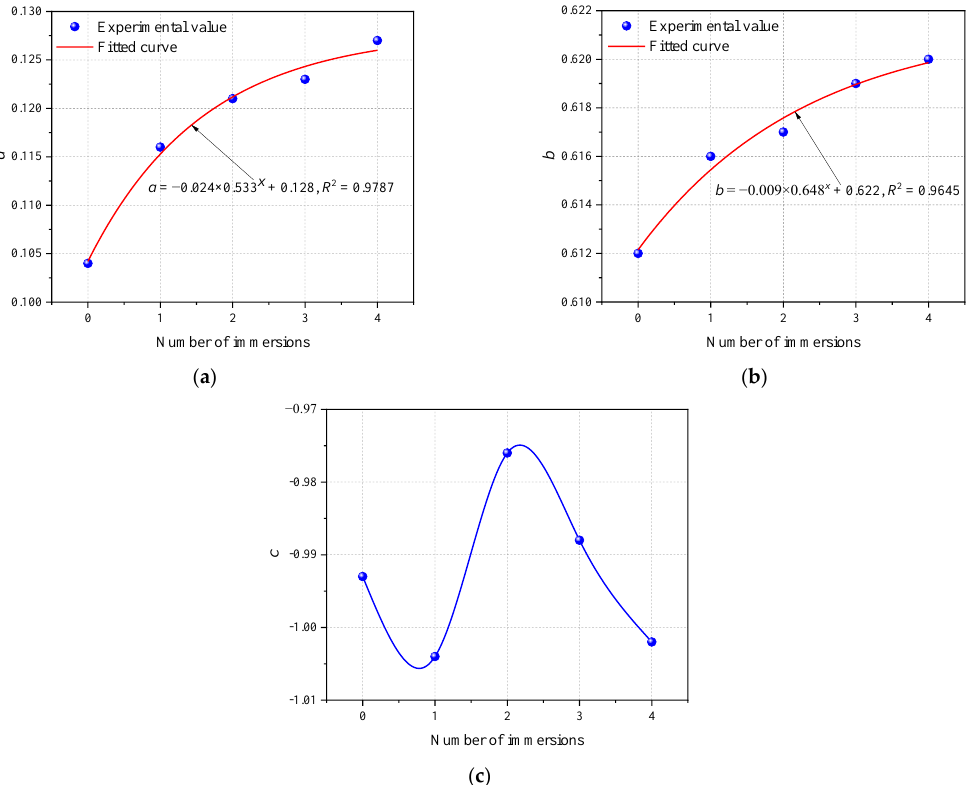
Figure 13. Relationship between fitting parameters and immersion times. ( a ) a , ( b ) b , and ( c ) c . As shown in Figure 13, with an increase in the immersion time, parameters a and b increased exponentially, and the change in parameter a was more evident than that of parameter b . Parameter a of the dry gangue sample was 0.104, whereas parameter b was 0.612. When the sample was soaked four times, parameter a increased to 0.127 and param- eter b increased to 0.620, which translated to 22.1% and 1.3%, respectively. Parameter c had no evident regularity with the increase in the immersion time and had a small range from − 1.004 (immersion twice) to − 0.976 (immersion three times).